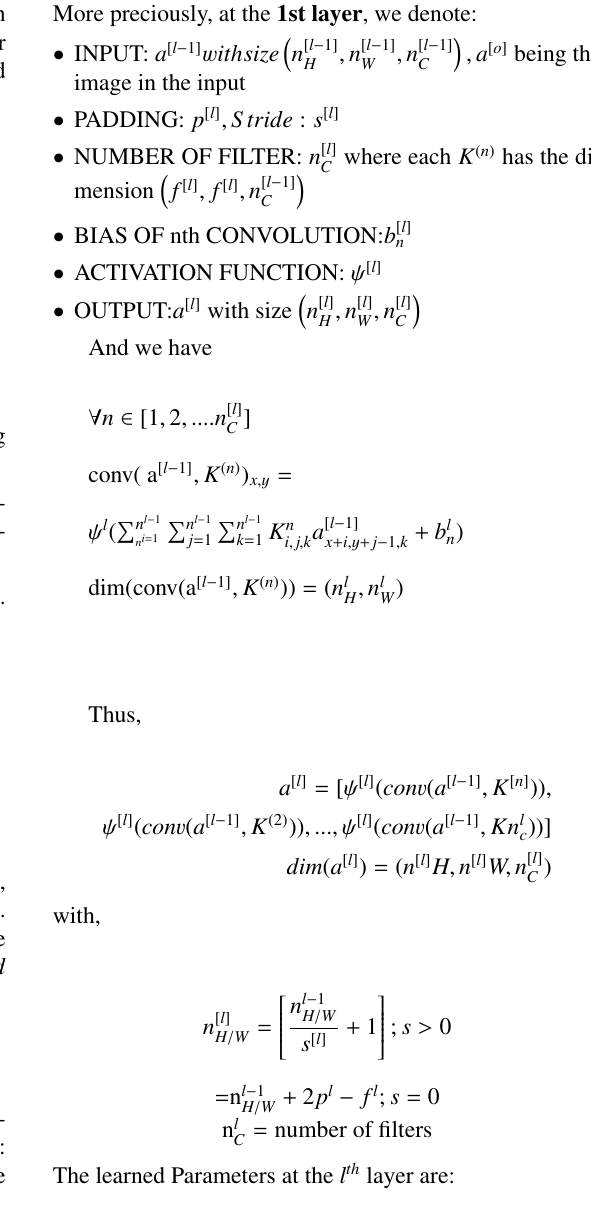
feature analysis in CNN followed by LSTM and GRU models, and a single probability value is Figure 2. deepfaken creation model using two encoder-decoder